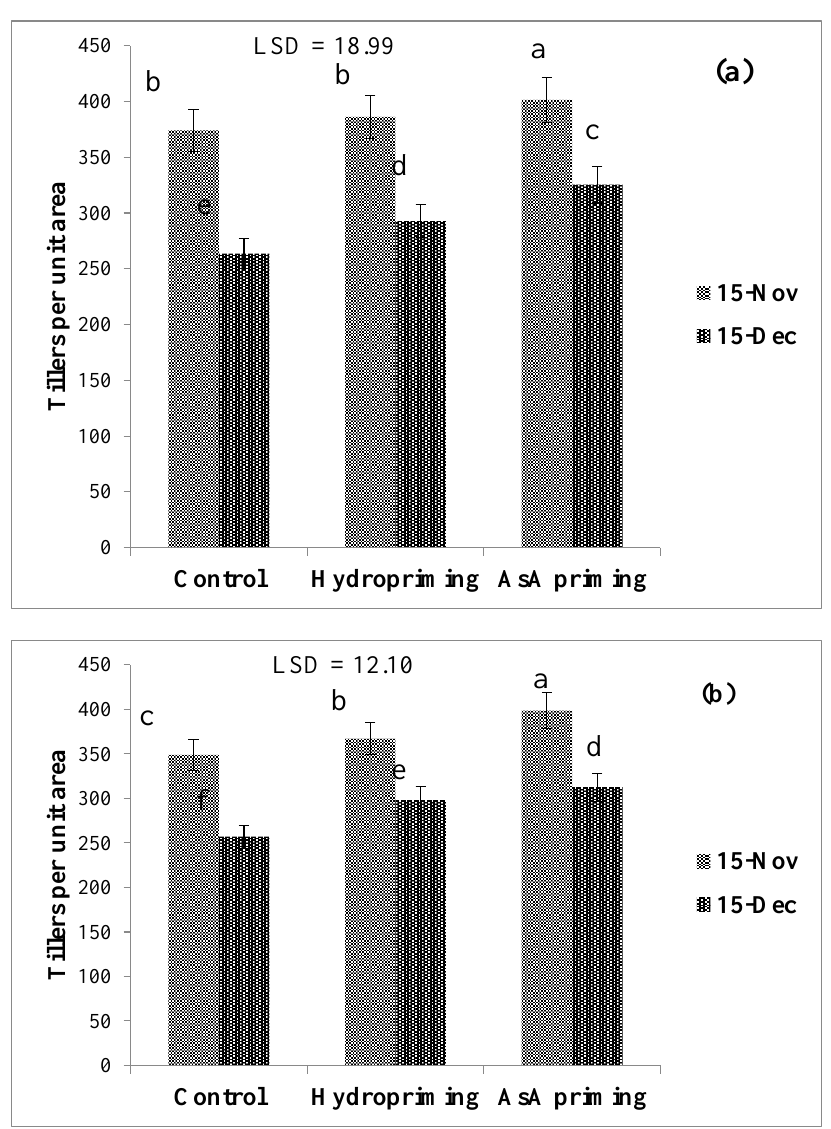
Figure 7. ( a , b ) Interaction between priming techniques and sowing dates for tillers per unit area during 2016-17. Means not sharing same letter (s) differ significantly at p ≤ 0.05.